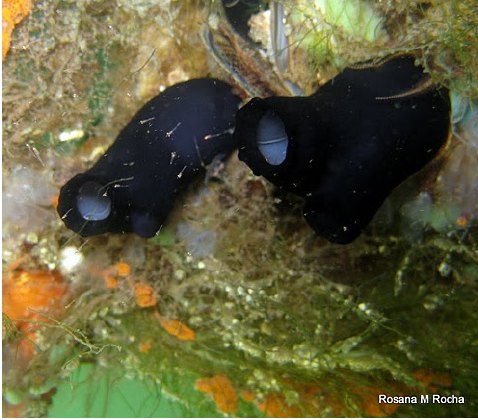
Figure 30. An image of Phallusia nigra . © Rosana M. Rocha; http://invasions.si.edu/.